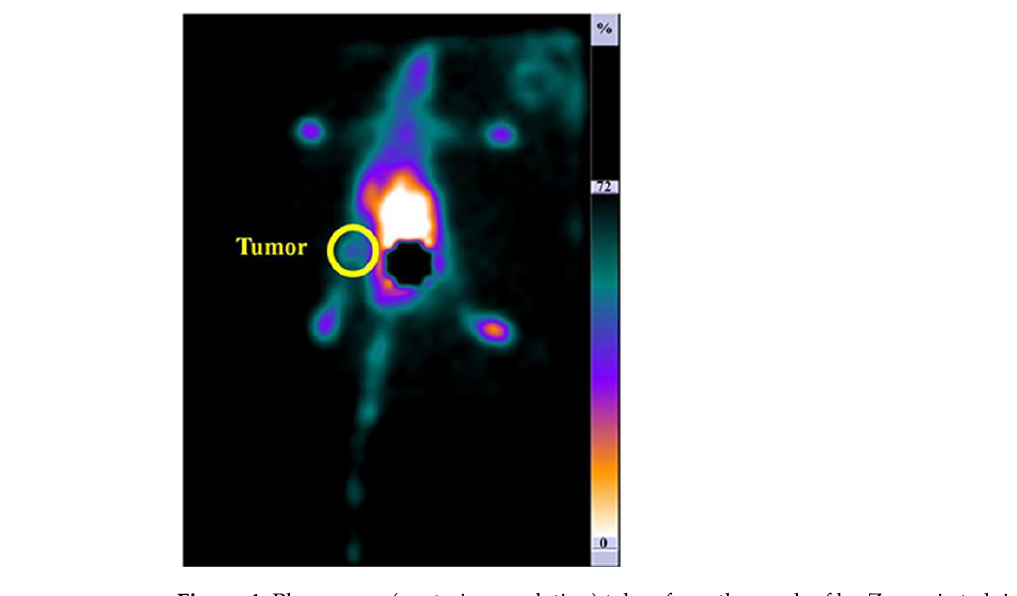
Figure 4. Planar scan (posterior revelation) taken from the work of by Zamani et al. in breast cancer- bearing mice 60 min after the injection of the 99m Tc — (PEG)-citrate dendrimer-G3 linked to folic acid. In the yellow circle, the tumor site.